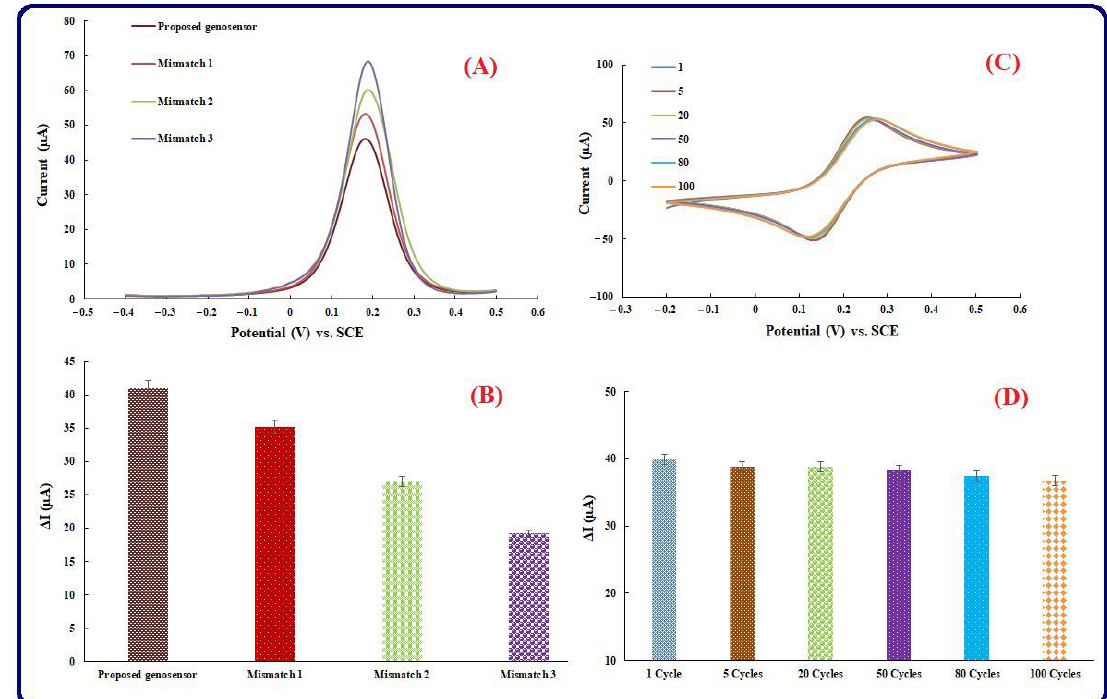
Figure 7. ( A ) Selectivity of the fabricated genosensor: DPVs of the engineered genosensor in hy- bridization by miRNA-21, 1-mismatch miRNA-21, 2-mismatch, and 3-mismatch miRNA-21. The scan rate is 50 mV s − 1 . ( B ) Histograms of the proposed genosensing assay selectivity, ( C ) CVs of modified Au electrode in different cycle numbers. ( D ) Histogram associated with different cycle